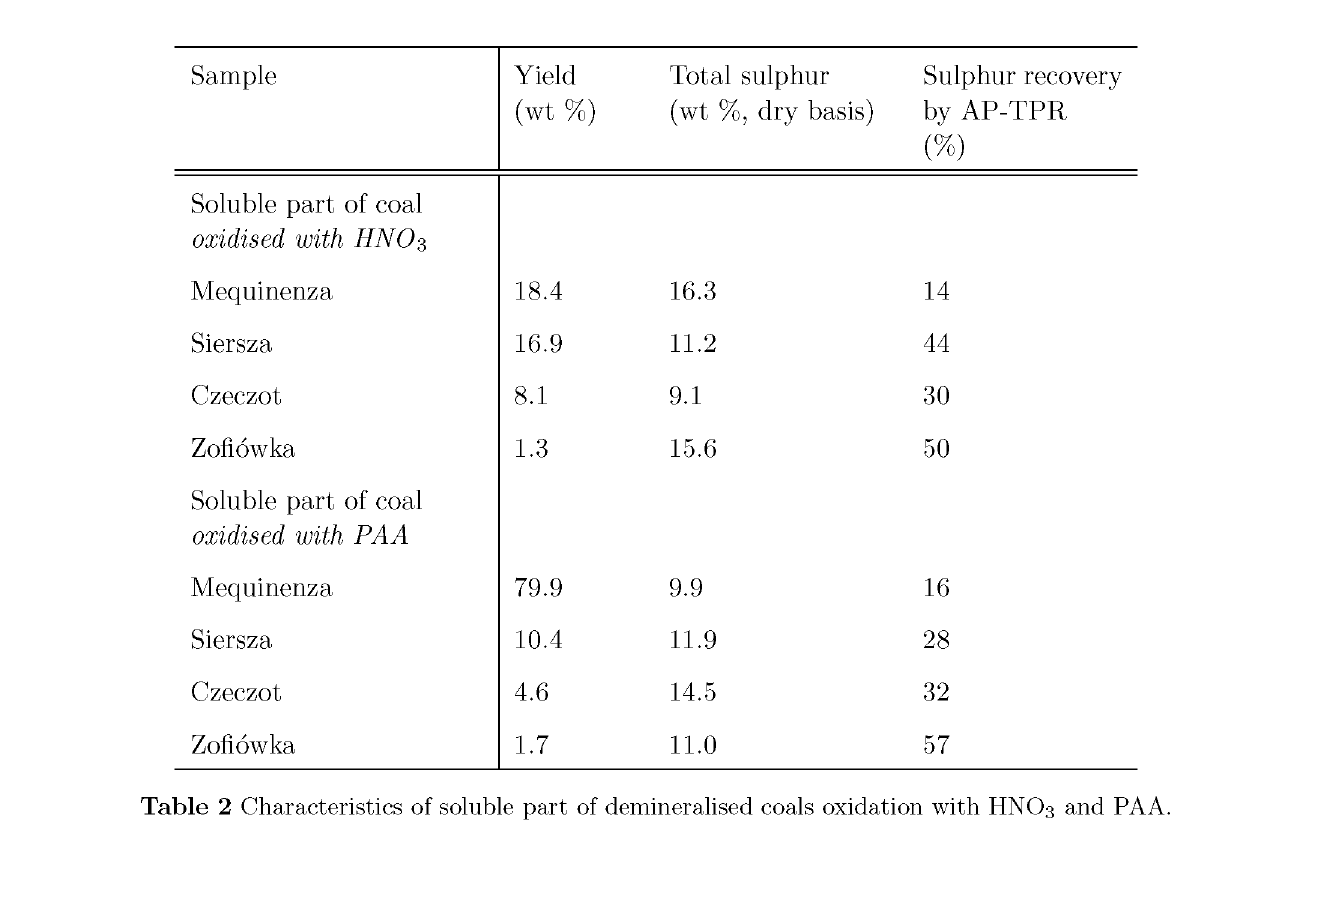
Table 2 Characteristics of soluble part of dernineralised coals oxidation with HNO3 and